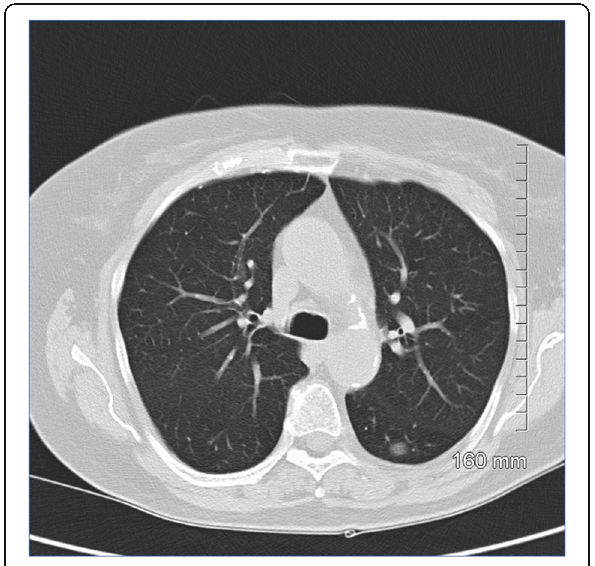
Fig. 1 AIS on CT. A 10-mm pure ground glass nodule in the left lower lobe. Stable in size for 3 years prior to biopsy